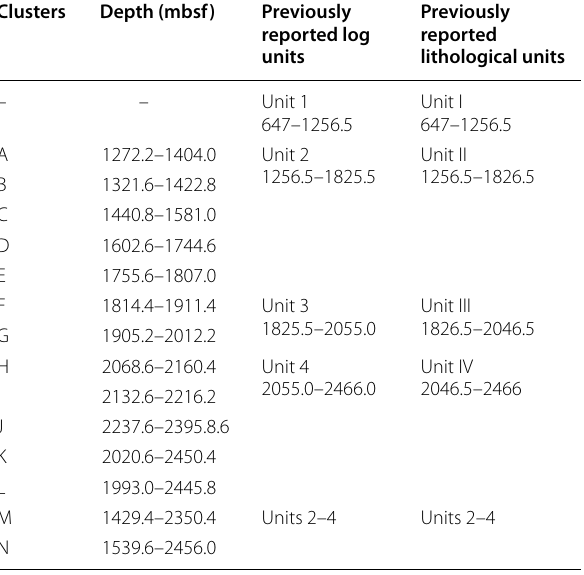
Table 3 Clustering results for Site C0020